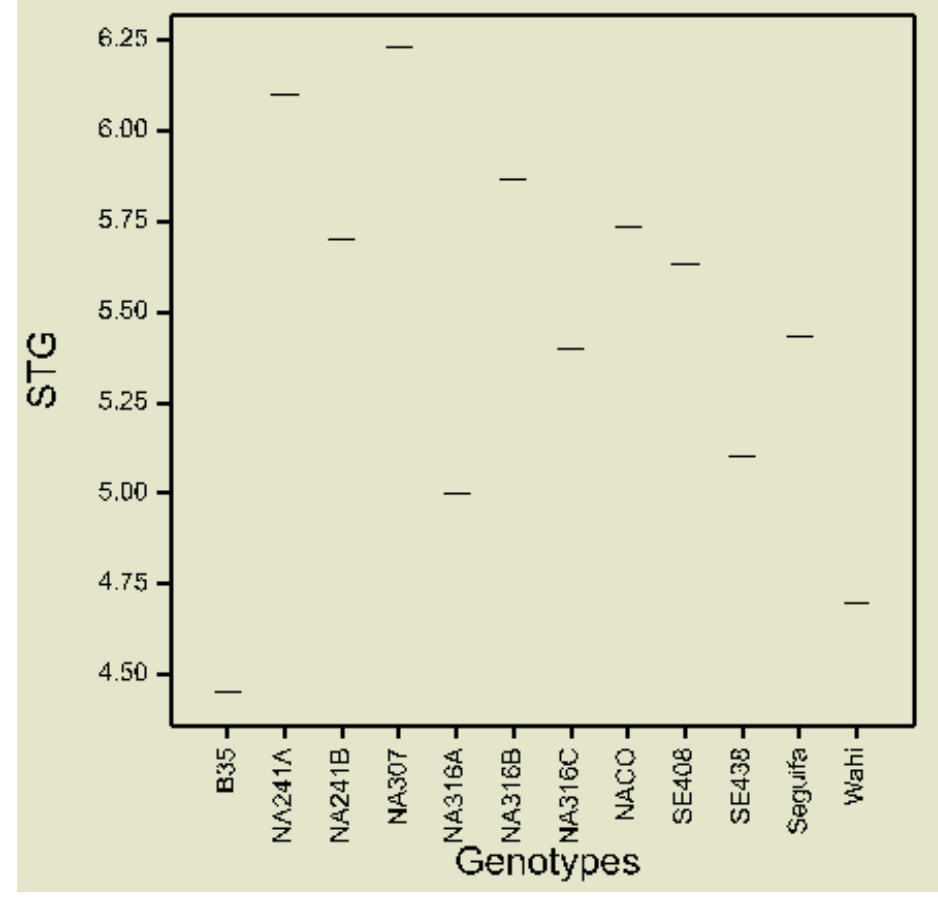
Figure 2. Boxplot of mean STG of BC 2 F 3 genotypes and parents across well ‐ watered and water ‐